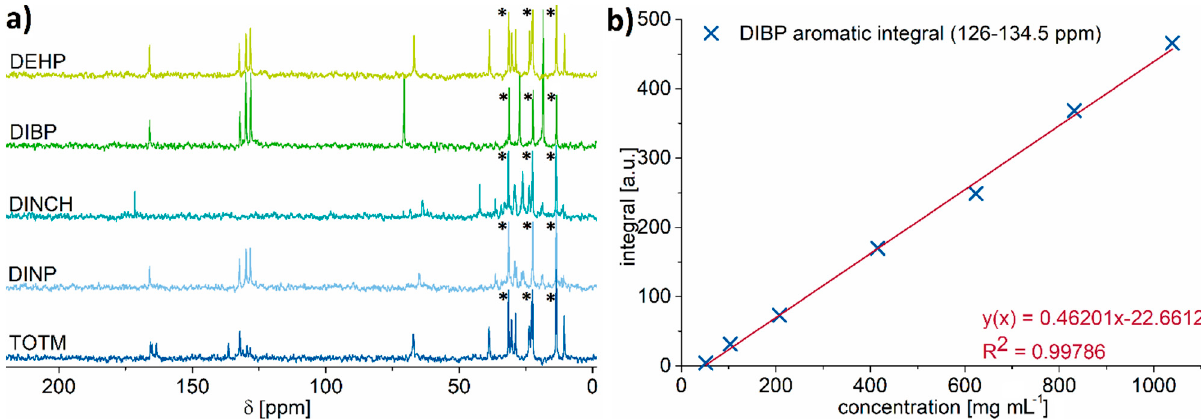
Figure 4. ( a ) 13 C low-field NMR spectra recorded with a plasticizer concentration of 60 vol.% in non-deuterated n-hexane (signals marked with asterisks). The asterisks correspond to the signals from n-hexane. ( b ) Integral versus concentration plot showing excellent linear behavior as illustrated by the aromatic region of DIBP.